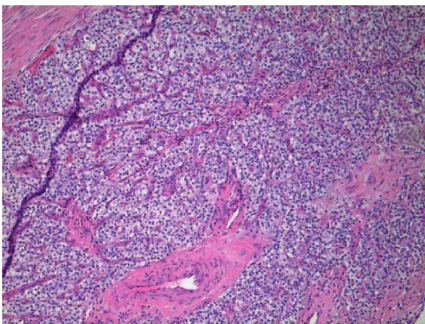
Figure 3: A hematoxylin and eosin stain clearly showing a well- defined rim of encapsulated hypercellular parathyroid tissue composed of chief cells and oxyphil